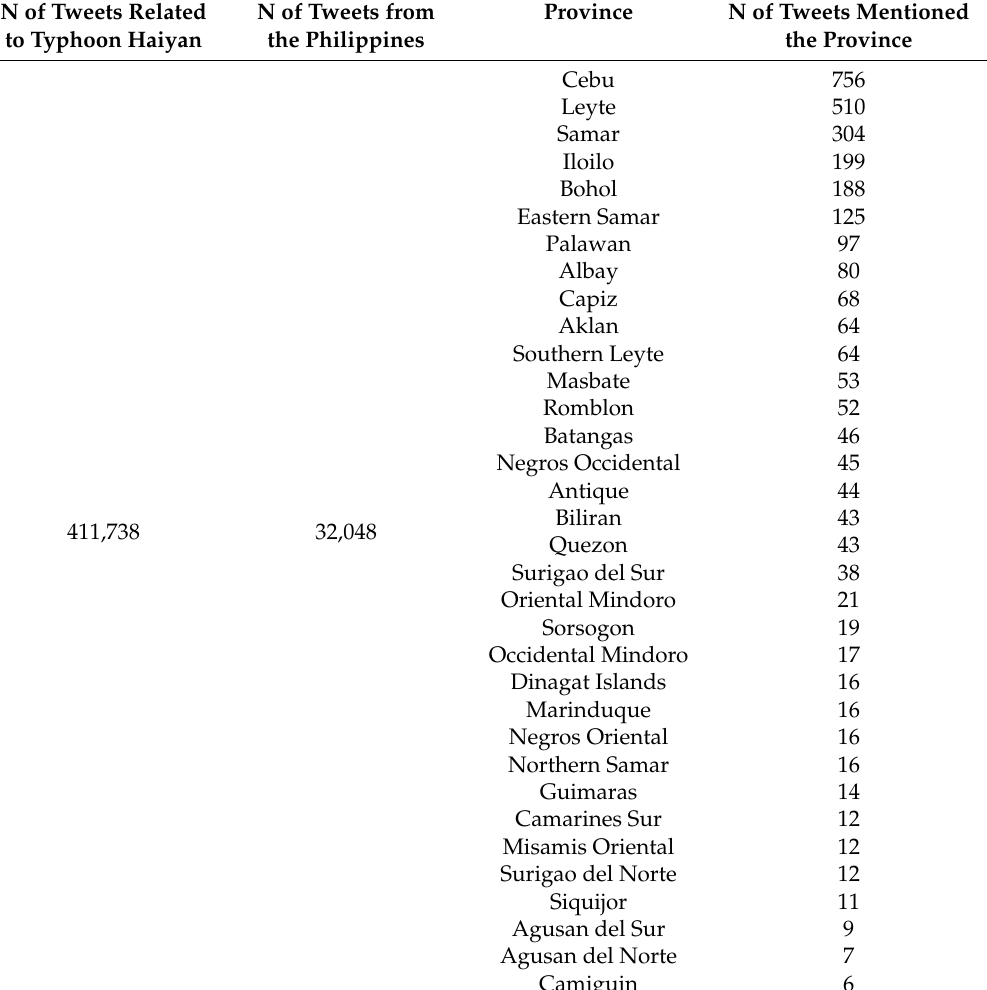
Table 1. The number (N) of tweets in each procedure. N of Tweets